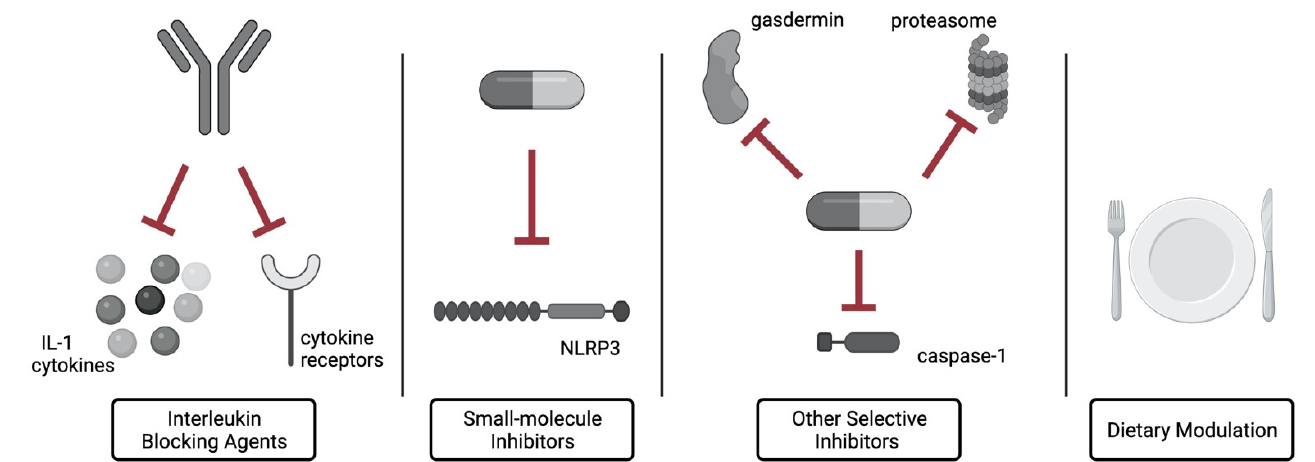
Figure 3. The summary of the inflammasome-modulating approaches. Interleukin blocking agents: antibodies neutralizing cytokines of IL-1 family and their receptors. Small-molecule inhibitors: molecules that directly inhibit the inflammasome components (e.g., MCC950). Other selective inhibitors: molecules selectively inhibiting gasdermin, caspase-1 or proteasome. Dietary modulation: modulating intestinal inflammasome response by change of diet composition. Created with BioRender.com (accessed on 10 July 2022).